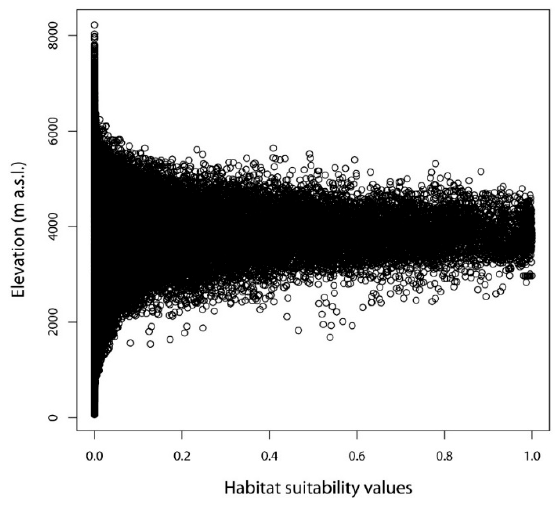
Figure 11. Altitude of the potential suitable areas under current climate conditions.